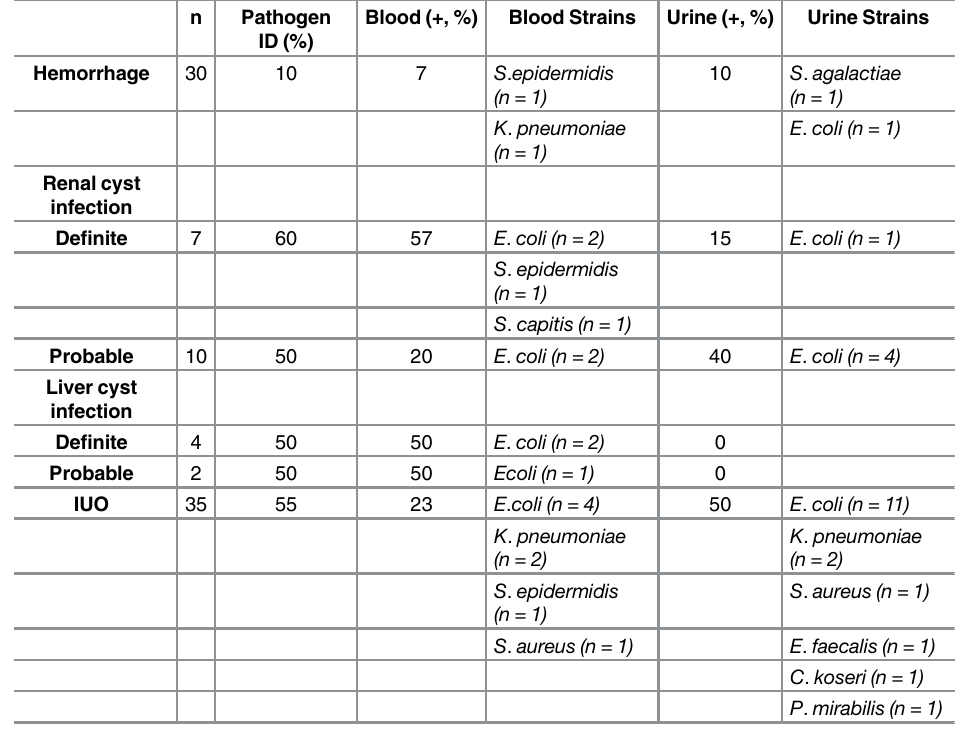
Table 2. Bacteriological